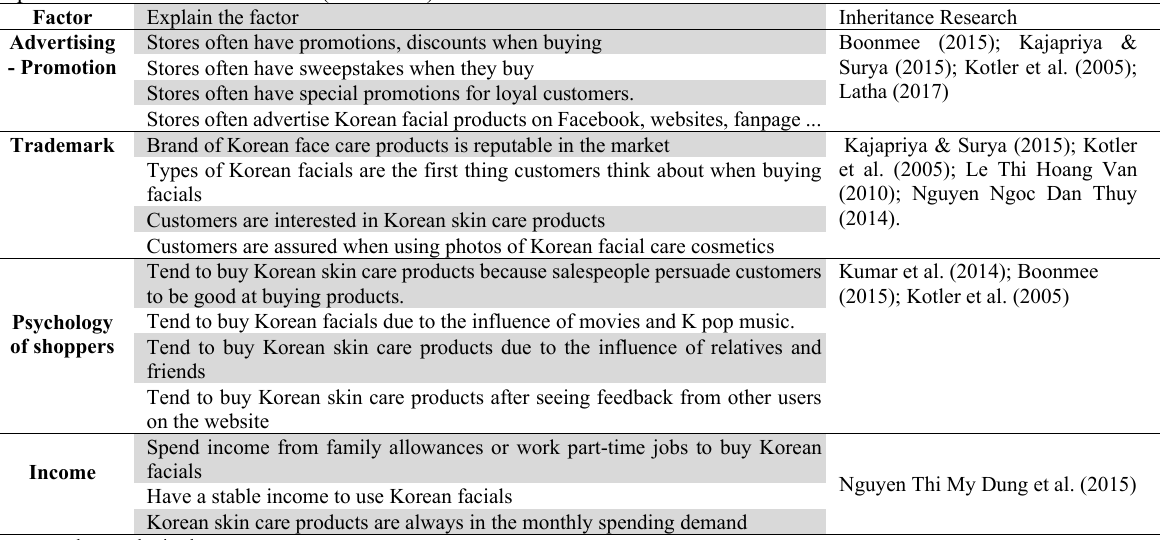
Explain the variables of the model